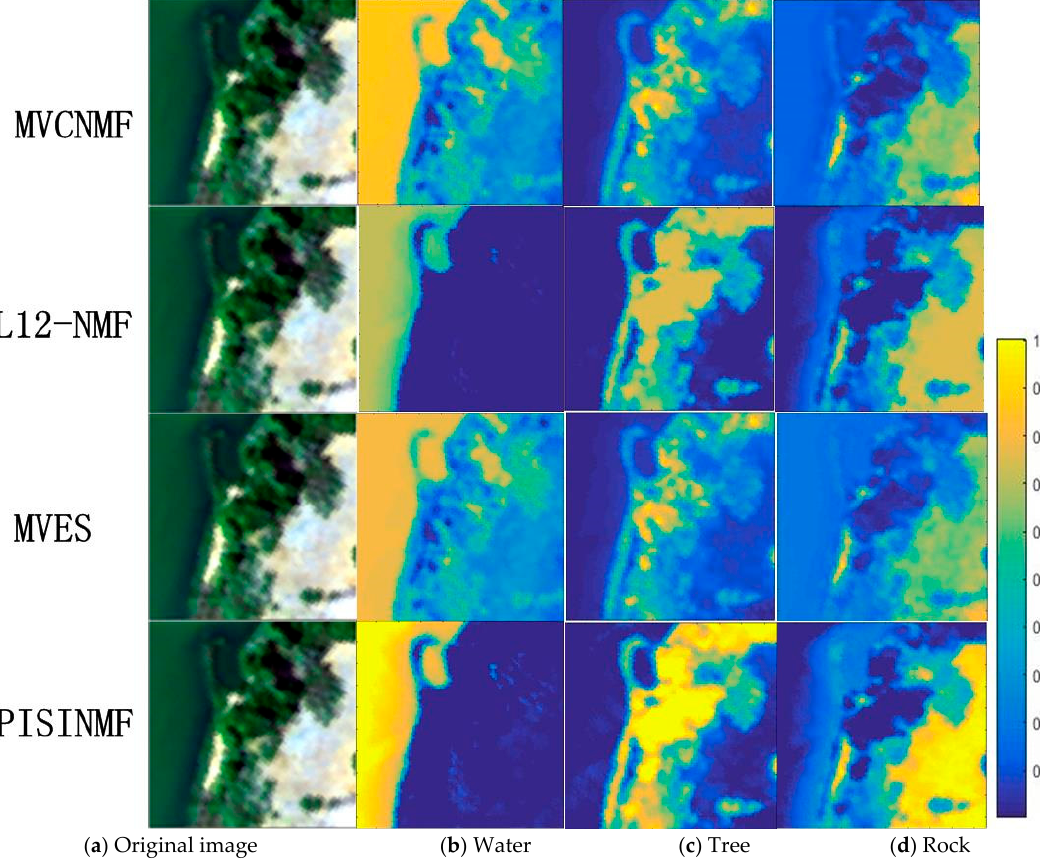
Figure 14. Abundance maps of MVC-NMF, MVES, L 1/2 -NMF, and PISINMF for the Samson dataset: ( a ) Original image; ( b ) Water; ( c ) Tree; ( d ) Rock.